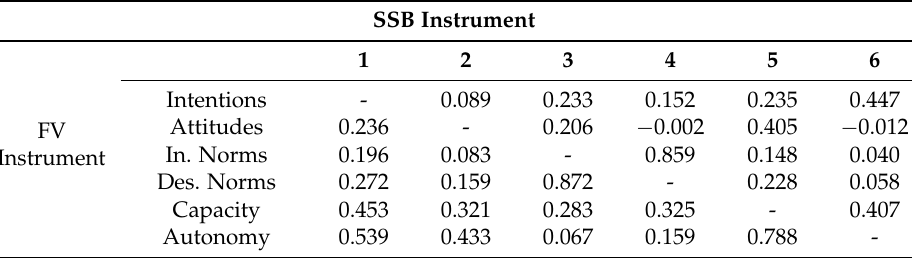
Table 3. Pairwise correlation analysis of the latent variables.